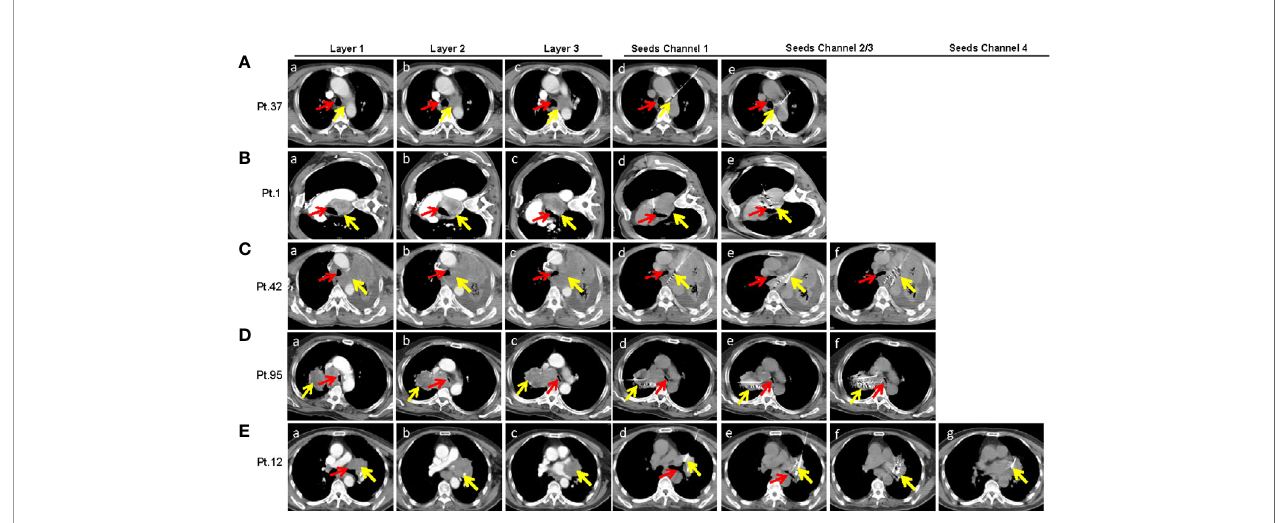
FIGURE 7 | SNCP- 125 I brachytherapy is a unique approach in treating thoracic malignancies with limited numbers of accessible anatomic puncture site as shown in several representative cases. (A) A lung tumor in Patient 37 was surrounded by the main trachea, aortic arch and left pulmonary artery (a – c). To avoid damage to large blood vessels, only one CT layer could be the gap for needle insertion, which was less than 1 cm (c). The puncture had to pass through the whole left lung (10 cm from the tumor) that only allowed a single needle insertion (c). The fi rst puncture was done under the aortic arch (d), and the second and third puncture through the right pulmonary artery by adjusting the needle in the aortic window without exiting the vascular space (e). (B) A lung tumor in patient 1 in the aortic window compressed the main trachea. The patient was only able to lie on the left side due to breathing dif fi culty, and this greatly limited the operation time (a – c). The fi rst puncture was done through the intercostal space and the aortic window (d), and the second and third punctures by adjusting the direction of the needle from the edge of the diaphragm (e). (C) An irregular left lilar tumor in Patient 42 invaded the mediastinum, oppressed the left main trachea and the esophagus (a – c). The needle was inserted into the posterior mediastinum through the left anterior chest wall and the left hilum (d). Withdrawing the needle until 1cm from the edge of the tumor and changing puncture direction for the second punctures (e, f). (D) A right hilar tumor in Patient 95 invaded the mediastinum, oppressed the main trachea which was narrowed by nearly 80% (a – c). Only one needle could be inserted into the side chest wall with a total puncture path of about 20 cm to reach the distal side of the tumor because the tumor in the mediastinum that compressed the trachea was blocked by the superior vena cava and aorta (c). Both the fi rst and second punctures reached the dorsal side of the tumor which formed a conical distribution with the third puncture (d – f). Particularly, the operation was required to be completed in 5 to 10mins due to breathing dif fi culty. (E) A left hilar tumor in Patient 12 invaded the hilar, heart and trachea (a – c). Four punctures were superimposed due to the large size of the tumor. The four punctures were done through the intercostal space (d – g). Scans of each patient were enhanced continuous CT scan with a thickness at 5mm. Yellow arrow-tumor, Red